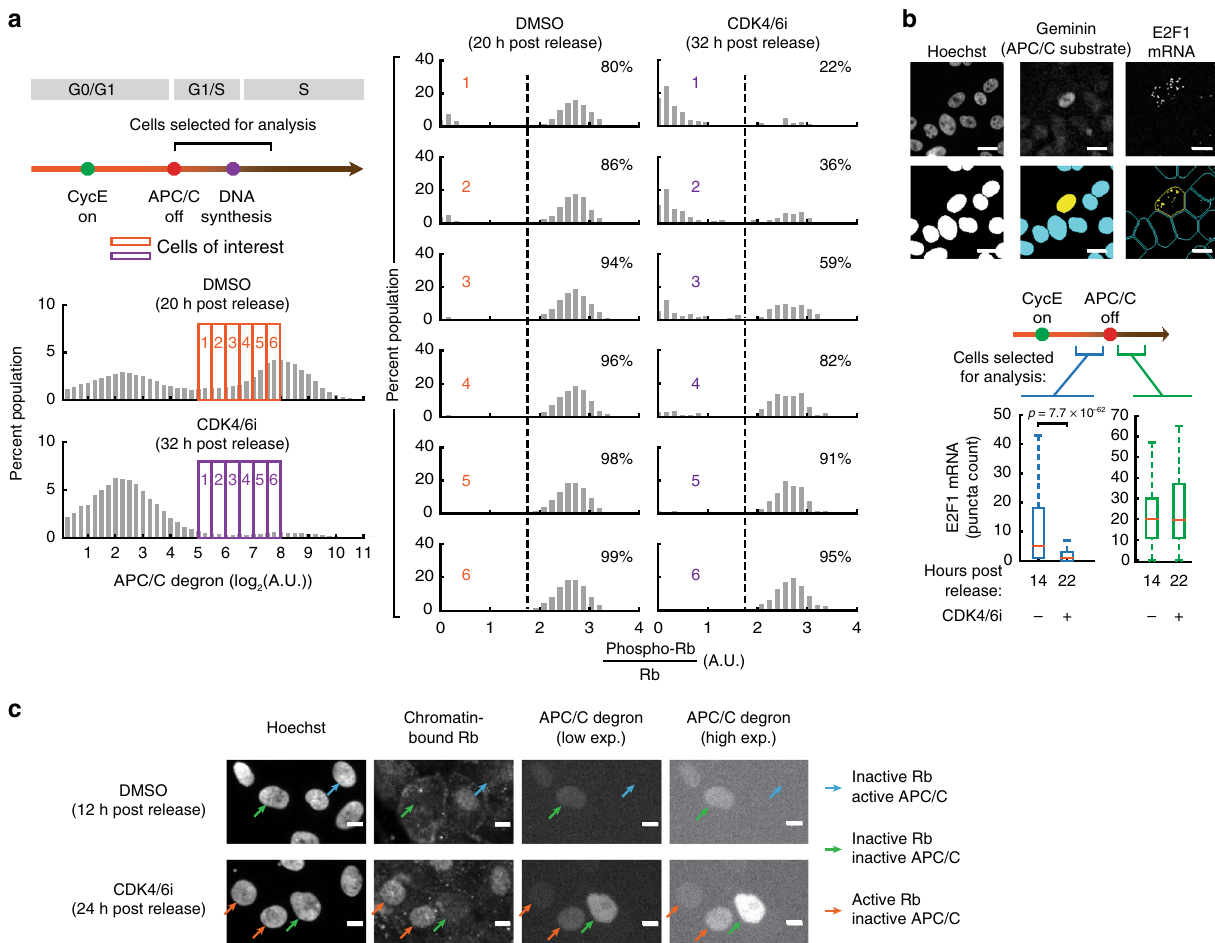
Fig. 4 The canonical signaling order of Rb inactivation before APC/C CDH1 inactivation is reversed in cells proliferating without CDK4/6 activity. a Cells mitogen released with DMSO or 1 µ M CDK4/6 inhibitor and have recently inactivated APC/C CDH1 were analyzed for phospho-Rb(S807/S811) signal (>800 cells per histogram for DMSO > 200 cells per histogram for CDK4/6 inhibitor; 1 of n = 3 biological replicates). b Top: Single-cell mRNA quanti fi cation (scale bar = 10 µ m). Bottom: E2F1 mRNA in cells released with or without CDK4/6 inhibitor. High cyclin E/A-CDK activity de fi ned as ratio of signal>0.7. p values calculated using two-sided, two-sample t tests (from left to right: n = 784, 1484, 638, and 98 cells). Box center indicates median, box edges denote quartiles, and whiskers extend to 1.5 times the interquartile range away from the box edges. One of n = 3 biological replicates. c Mitogen- released cells were assayed for chromatin-bound Rb. Green arrows: cells that have inactivated both Rb and APC/C CDH1 ; blue arrows: cells that have inactivated Rb but not APC/C CDH1 ; orange arrows: cells that have inactivated APC/C CDH1 but not Rb. Scale bar: 10 µ m. One of n = 2 biological